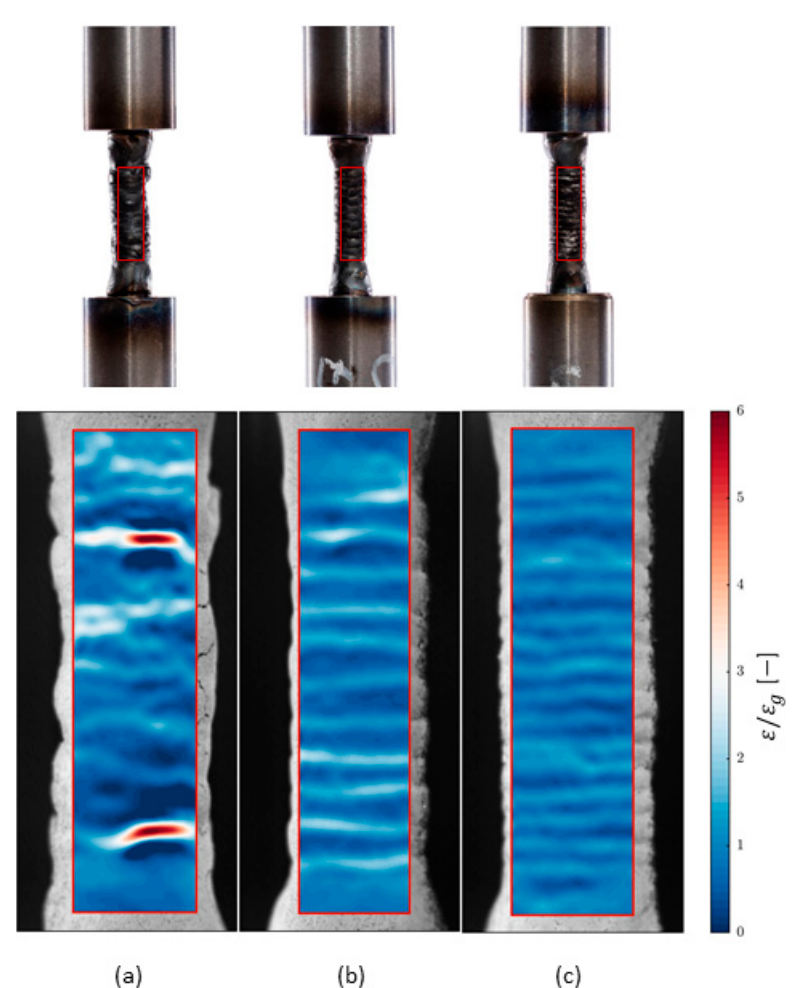
Figure 12. Photograph with the measurement area and local strain maps (longitudinal strain) related to the global strains of ( a ) conventional GMAW, ( b ) CMT standard, and ( c ) CMT cycle step under tensile load.